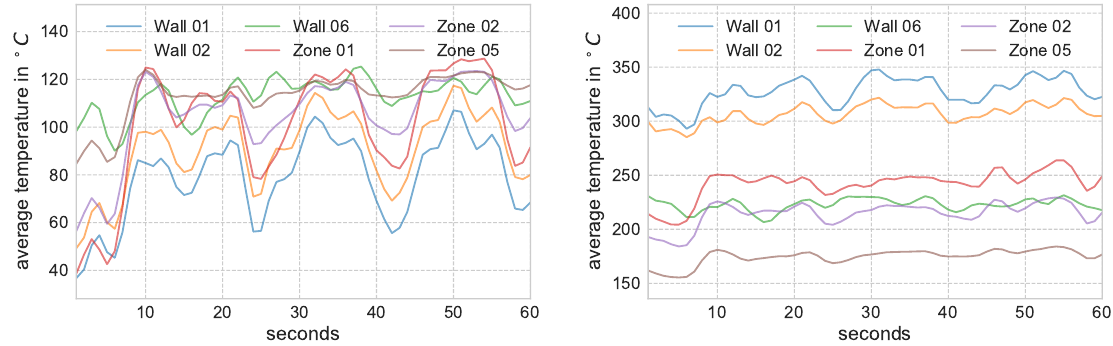
whole zones ( LE WZ ).